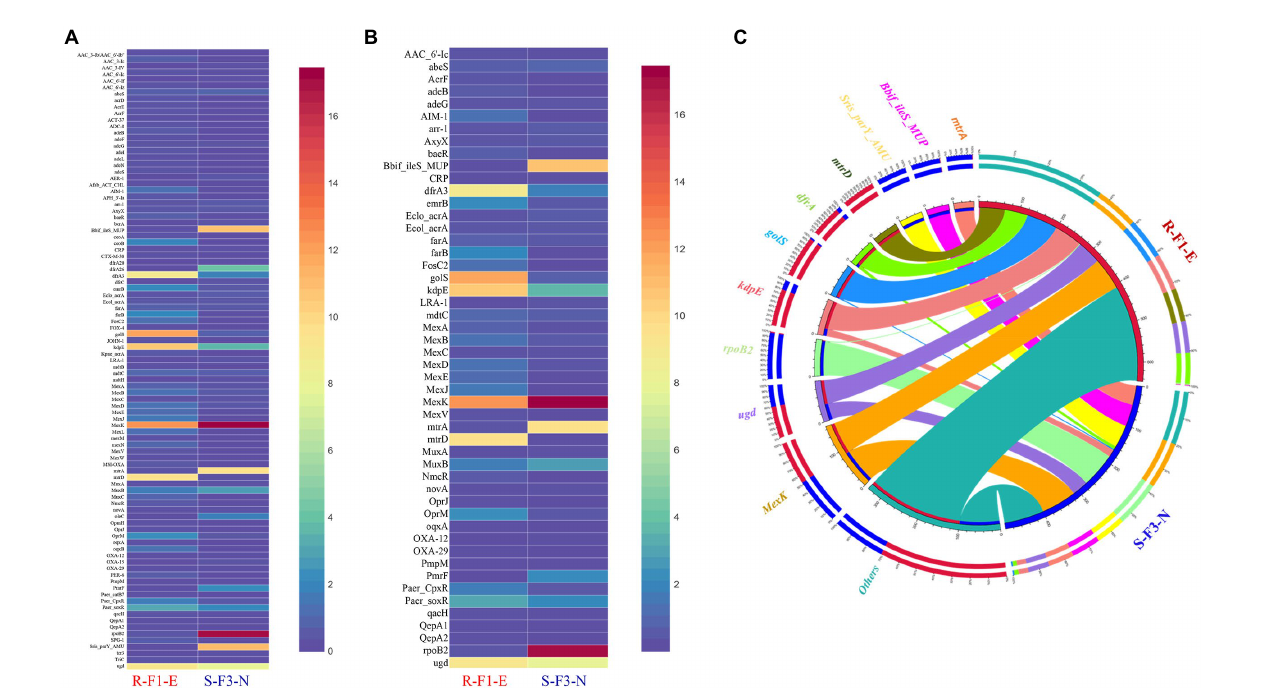
FIGURE 4 Distribution heatmap to represent (A) comparison of relative abundance of a total 95 Antibiotic resistance gene (ARG) profile obtained from sample R-F1-E and S-F3-N; (B) comparison of relative abundance of 50 ARGs shared between sample R-F1-E and S-F3-N. All the unique genes from the metagenomic assembly were blastp against Comprehensive Antibiotic Resistance Database (CARD). (C) Circos analysis displays the corresponding abundance relationship between samples and top 10 identified antibiotic resistance genes (ARGs) along with “others” representing remaining ARGs. Circle chart is divided into two parts. The right side of the circle is sample information, and the left side of the circle represents top 10 ARGs. Inner circle with different colors represents different ARGs. The scale represents the relative abundance, and the unit is ppm. The left part represents the sum of relative abundance of different samples for ARG, while the outer right circle represents the relative abundance of different ARGs in the